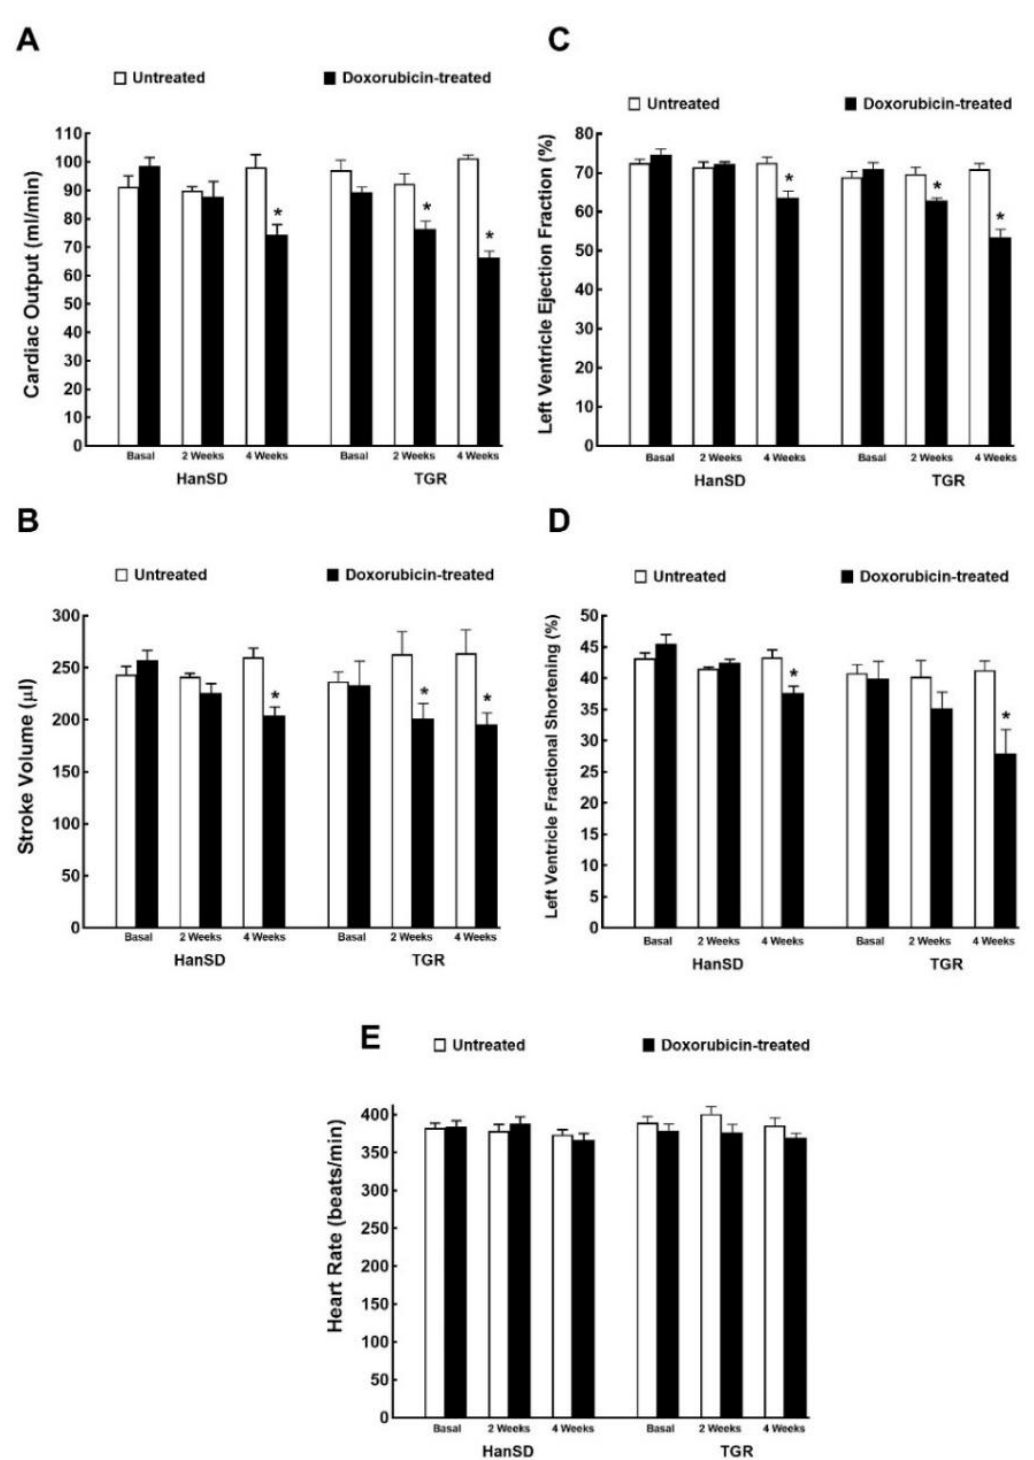
Figure 1. Assessment of the cardiac functional parameters by echocardiography before administration of doxorubicin (basal values), at the end of doxorubicin administration (2 weeks values) and two weeks after termination of doxorubicin treatment (4 weeks values) in normotensive, transgene-negative Hannover Sprague-Dawley (HanSD) and hypertensive, Ren-2 transgenic (TGR) rats. Cardiac output ( A ), stroke volume ( B ), left ventricle ejection fraction ( C ), left ventricle fraction shortening ( D ), heart rate ( E ). * p < 0.05 compared with untreated animals of the same strain at the same time point. The values are means ±